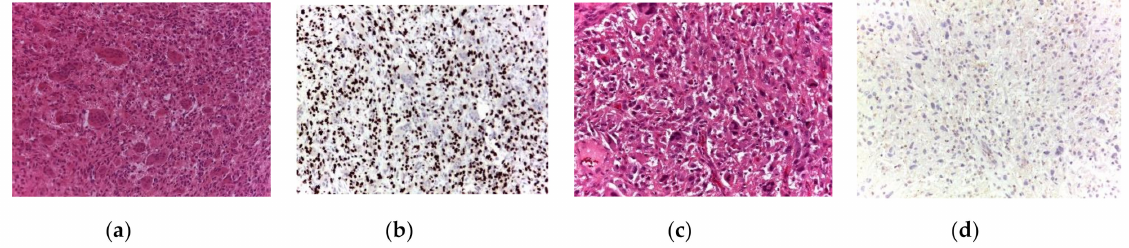
Figure 3. Histological specimens relative to secondary malignancy in giant cell tumor of bone. ( a ) Histology of the initial biopsy showing multinucleated giant cells embedded in oval, round mononuclear cells with hemosiderotic deposits; the lesion presents the appearance of a classic giant cell tumor (H&E, a , 200 × magnification), confirmed by immunohisto- chemistry to express the H3F3A protein G34W variant in mononuclear cells ( b , 200 × magnification). ( c ) Biopsy of the recurrent lesion, where a highly malignant neoplasm constituting spindled and pleomorphic cells can be observed. Upon immunohistochemistry analysis, the H3F3A protein G34W variant was lost ( d , 200 × of magnification).